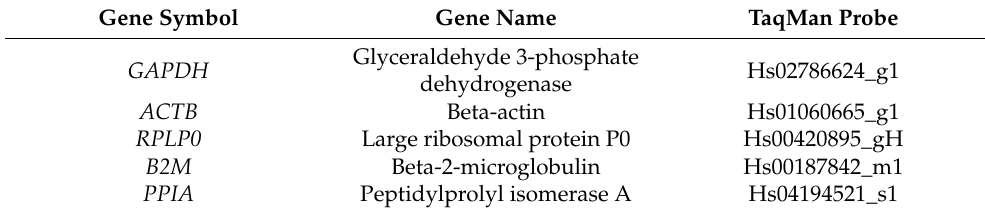
Table 2. Candidate reference genes used in the